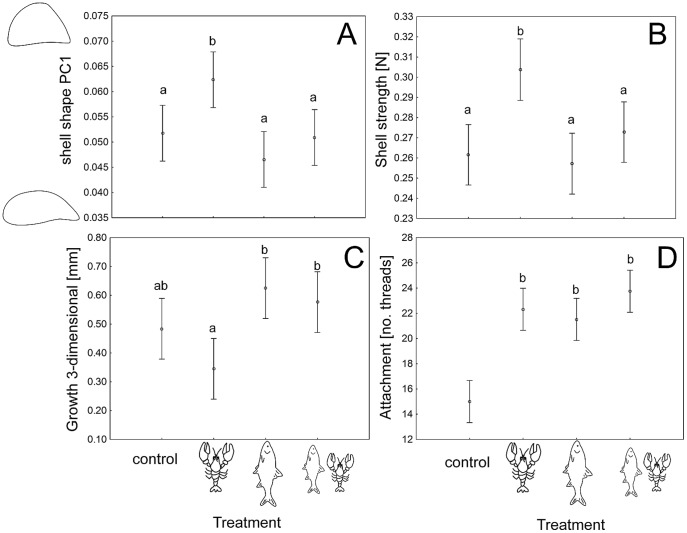
Zebra mussels' phenotype expression changes with predation risk.Anti-predator responses of zebra mussels from the four experimental treatments: either a single crayfish (crayfish symbol), a single roach (fish symbol), both predators combined (both symbols next to each other) or no predator at all (minus symbol). Different lower case a and b letters denote significant differences for p<0.05 after post-hoc tests. Error bars denote 95% confidence intervals A: shell shape expressed as a principal component PC1 explaining 77% of the total variation in the contour shape of all analyzed mussels (the contours on the y-axis depict ±2SD of the mean of PC1). B: shell strength as resistance to crushing in the form of the residuals from the correlation between mussel size and strength. C: growth measured in mm increase in the three shell dimensions length, height, and width compared to the start of experiment. D: Attachment strength as inferred from the number of byssus threads with which individual zebra mussels were attached to the surface.